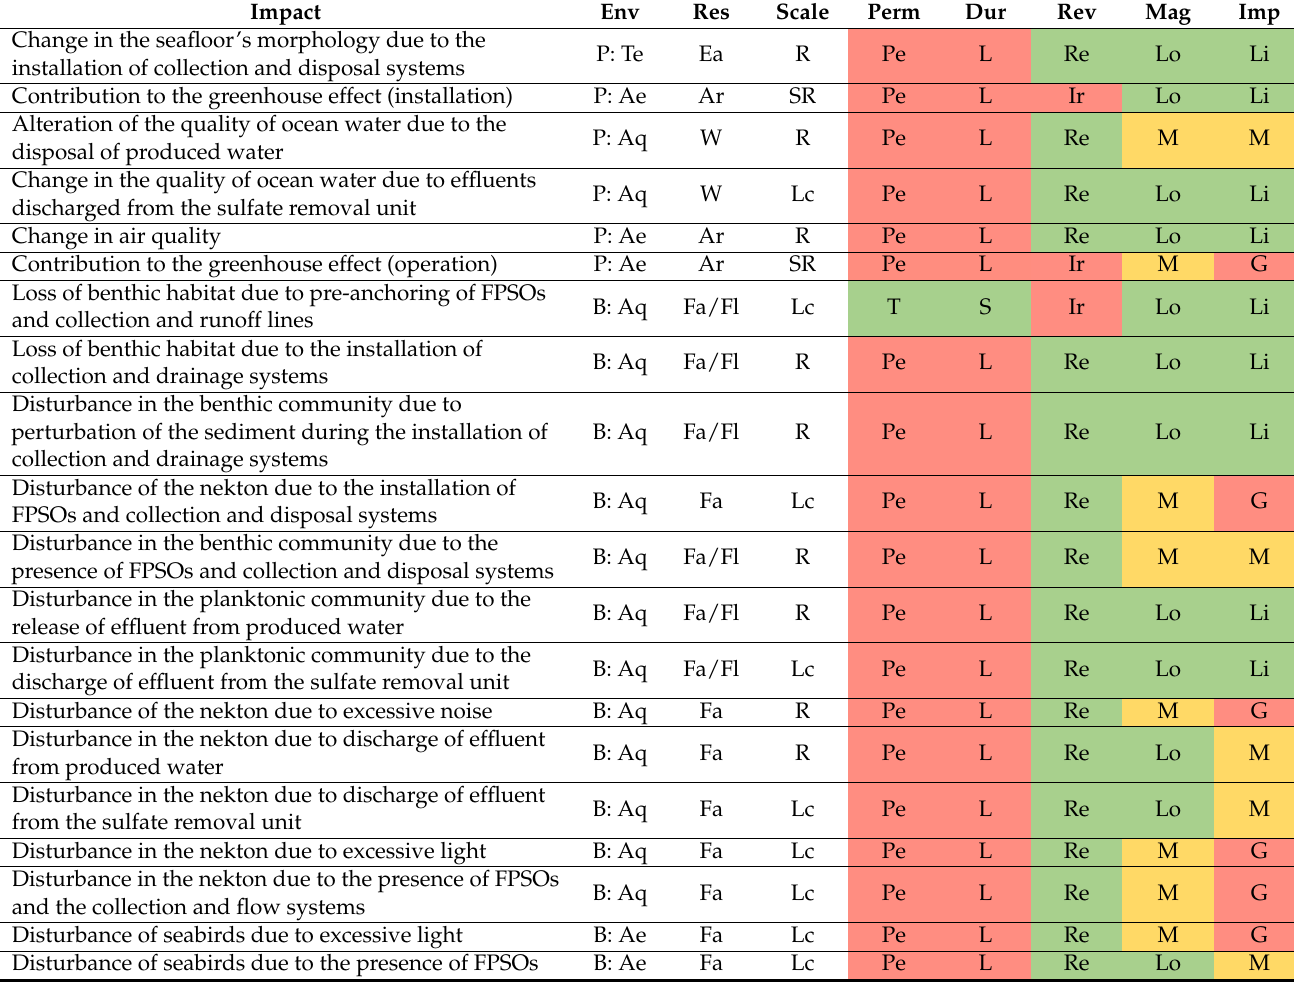
Table 7 lists the relevant environmental impacts caused during Stage 3. The key is as follows: Environment (Env): Biotic (B) or Physical (P), Aquatic (Aq), Terrestrial (Te), Aerial (Ae); Resource (Res): Fauna (Fa), Flora (Fl), Air (Ar), Earth (Ea); Water (W); Scale: Local